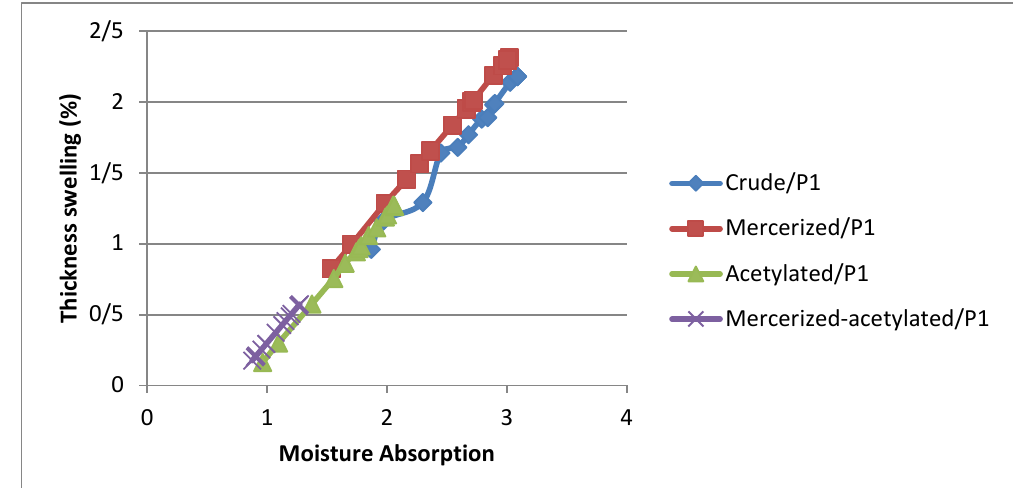
Fig. 13. Moisture absorption versus thickness swelling for P1 fibre contents among various fibre